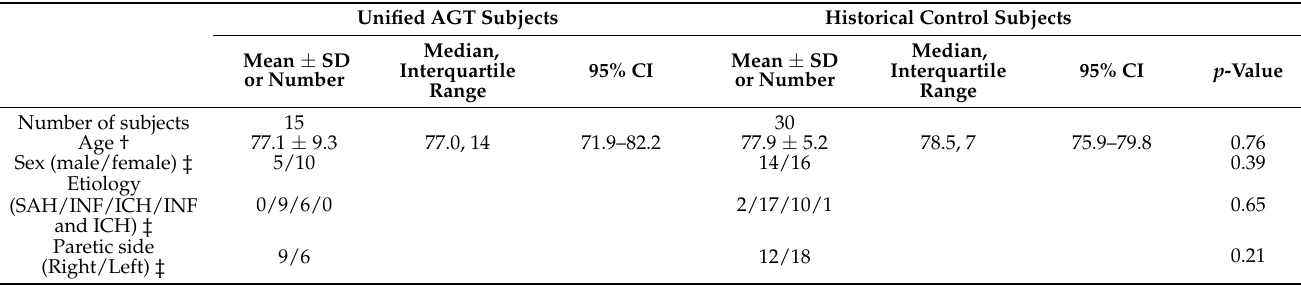
Table 1. Comparison of characteristics of alternate gait training subjects and historical control